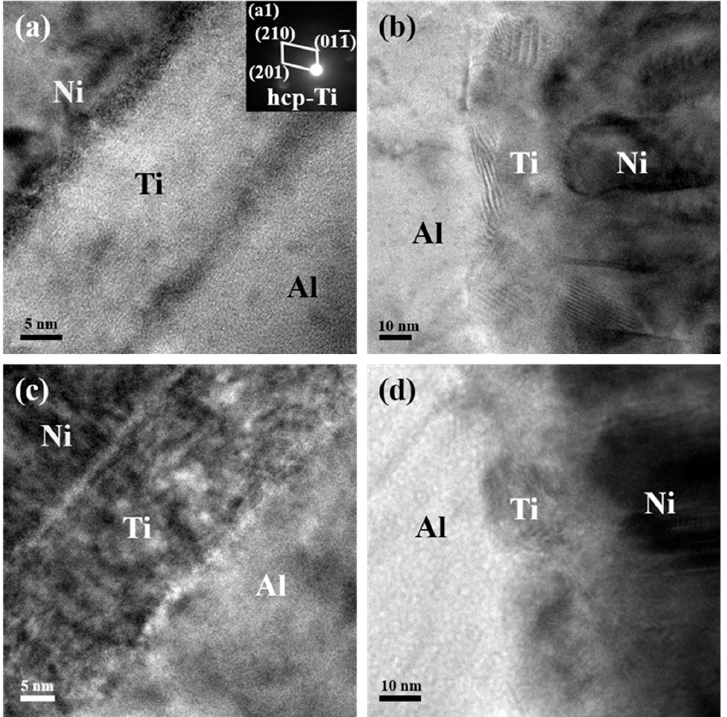
Figure 3. TEM images of the Ni/Ti/Al interface and Al/Ti/Ni interface for the as ‐ deposited ATNT foil: ( a , b ) the bottom region; ( c , d ) the upper region.